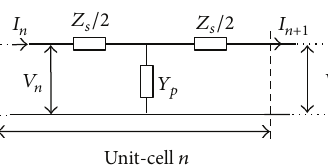
Figure 2: LHM unit-cell is described by symmetrical circuit